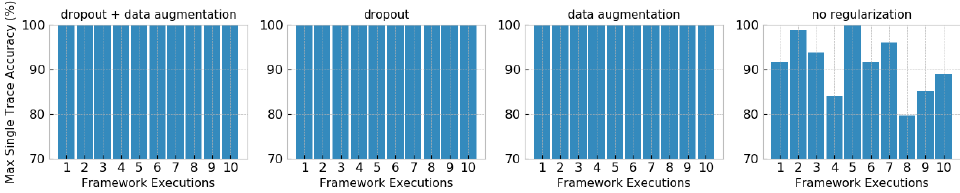
Figure 23: Random CNN hyperparameters: maximum single trace accuracy on the cswap- arith dataset for ten different framework executions and attacking the sample interval range from 1 500 to 3 500 of all